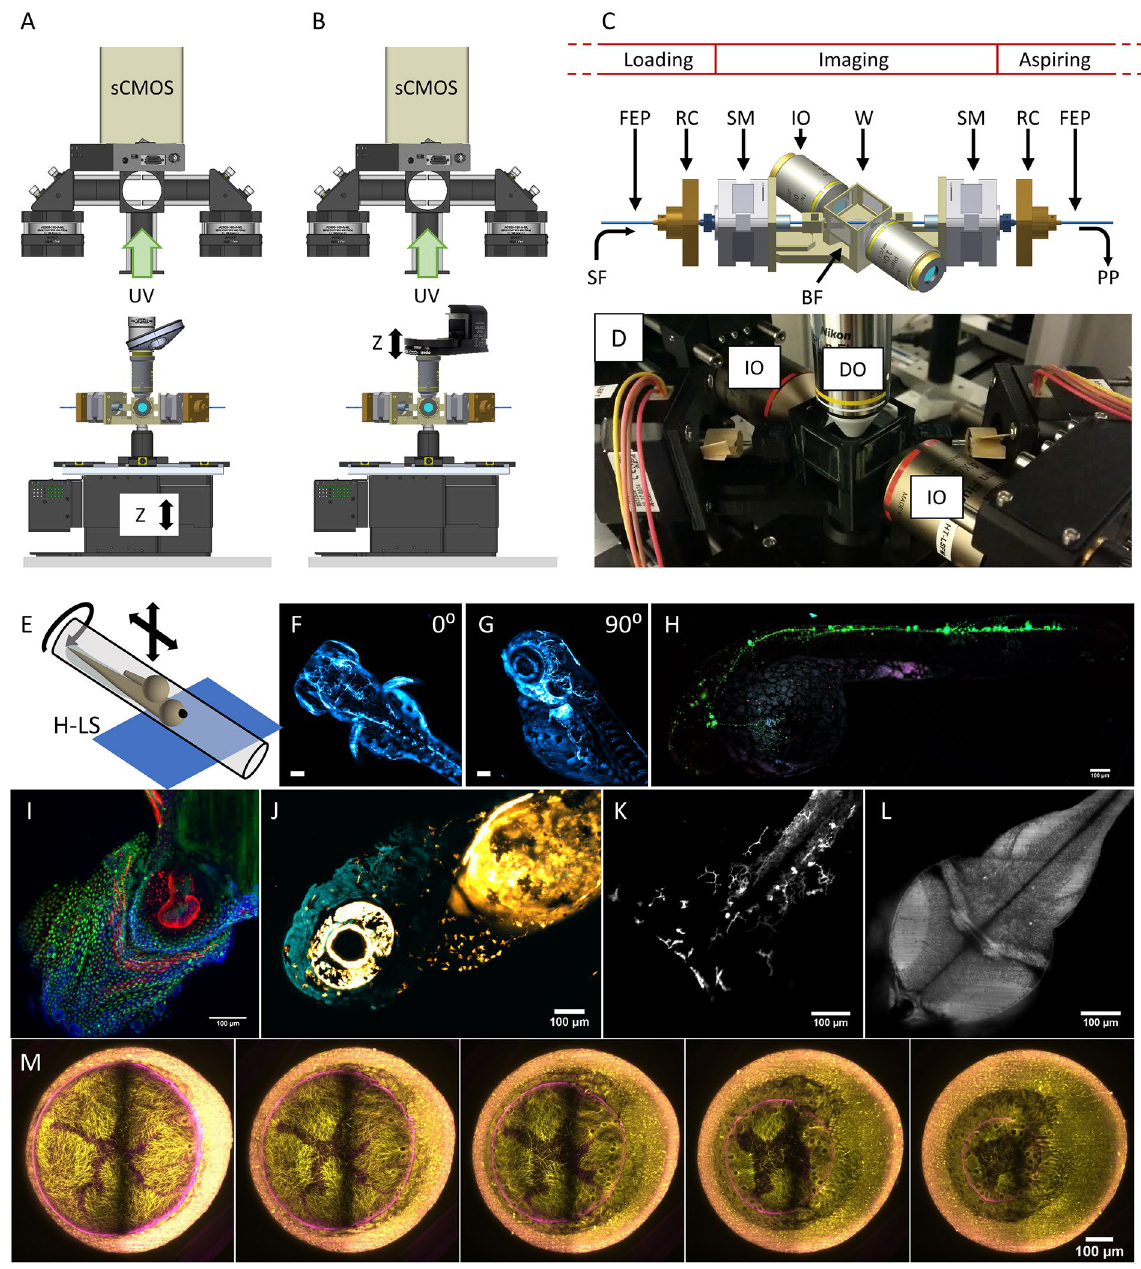
Figure 5. Setup implementation in the Hybrid LSFM modality with upright detection scheme and examples. The scanning in the depth (z) direction can be performed either ( A ) through a vertical stage moving the entire chamber or ( B ) through the displacement of the detection objective with a piezo-element synchronized with galvanometric scanning of the light sheet. Schematic ( C ) and actual implementation ( D ) of the imaging chamber for the Hybrid LSFM modality. ( E ) Exemplification of the sample mounting and scanning system. The sample flows within the FEP tube until the objectives’ FoV. There, it can be rotated around the FEP tube’s axis to orient the sample correctly (as shown in F , G ) and/or it can be moved in a controlled and stepwise manner along the tube, providing multichannel high-resolution whole larvae imaging by stitching ( H ). ( I ) The system allowed high-throughput imaging of zebrafish heart in a single imaging session (18 samples. The showed image was processed through a background correction method to decrease yolk’s auto-fluorescence). Full set of images in Supplementary Fig. 7. The use of a piezo focus control ( B ) allows fast imaging of macrophage migration in the head ( J ) and the caudal fin ( K ) as well as zebrafish brain’s neural activity using calcium indicators ( L ). More information in Supplementary Videos 5, 6 and 7. (M) Long-term multicolor time-lapse movies of zebrafish embryo development are also achieved. Scale bars: 100 µm. UV upper view, SF sample flow, RC rotational connector, SM stepper motor, W water compartment, PP programmable pump (not shown), BF bright field compartment, IO illumination objective, DO detection objective. ( A , B ) created with FreeCAD 0.16 (www.